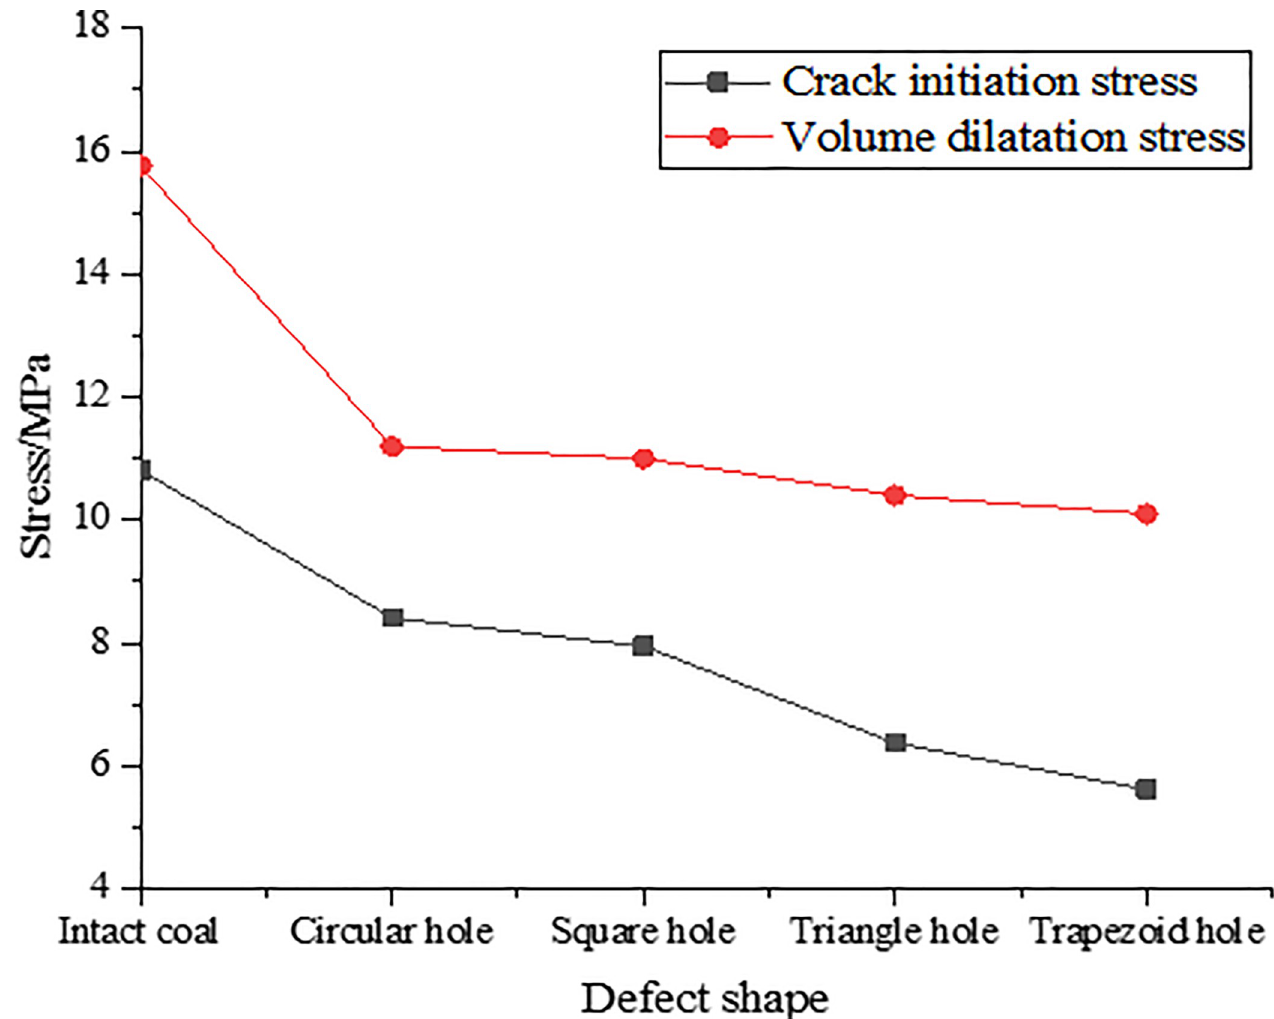
According to the data in Table 4, the relationship curves between initiation stress and dila- tation stress of complete coal and coal with different shapes of pores are drawn, as shown in Fig